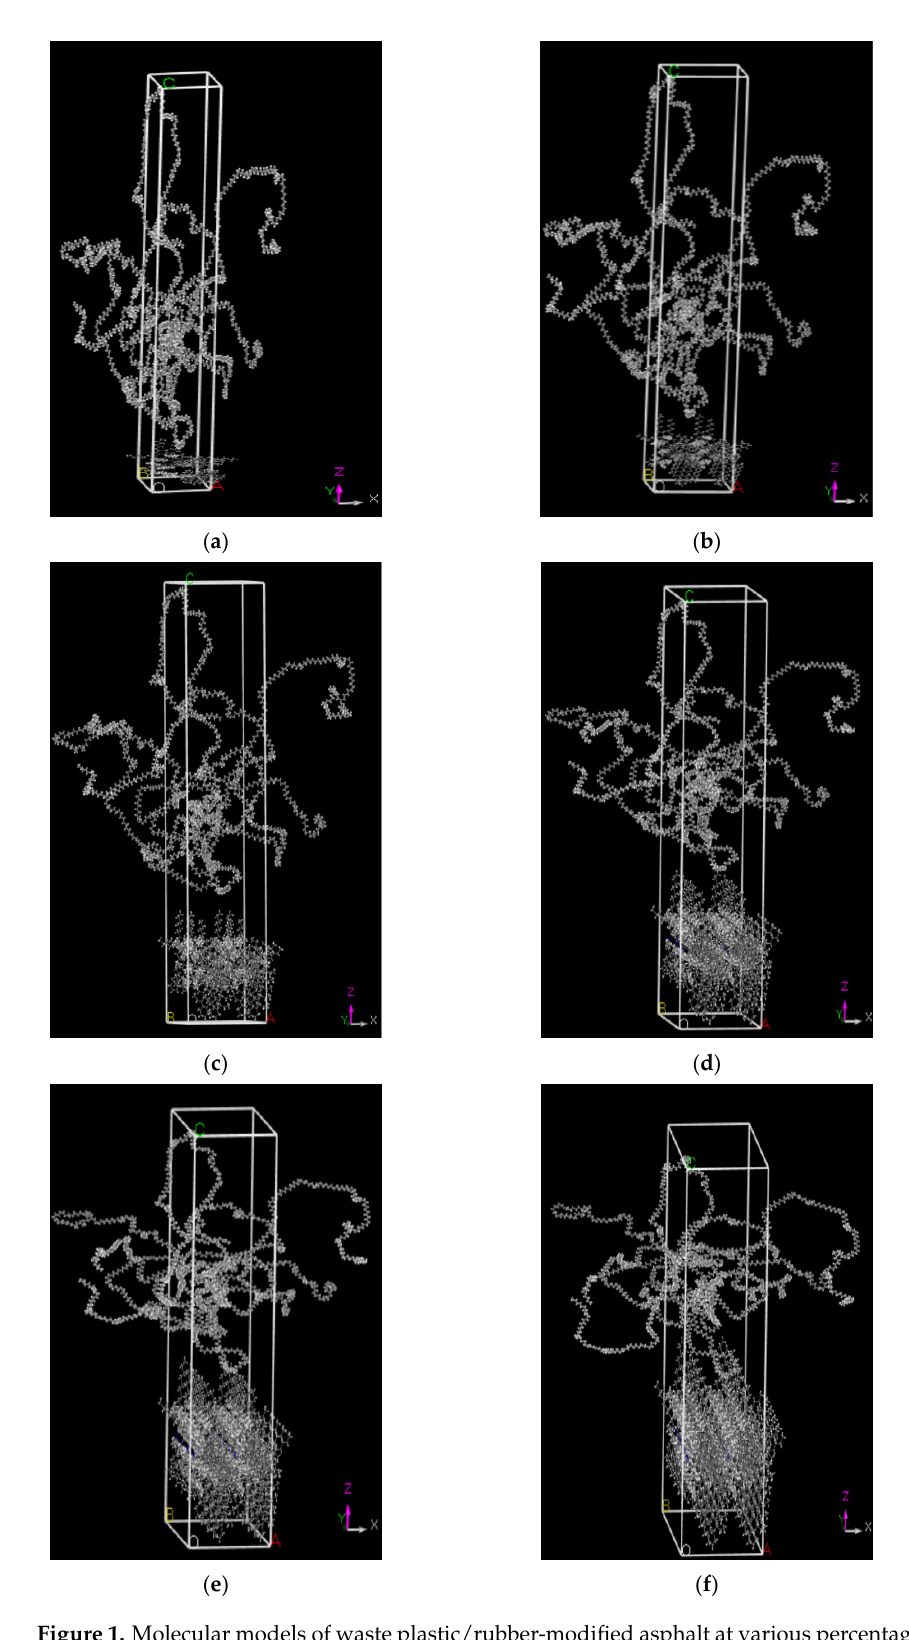
Figure 1. Molecular models of waste plastic/rubber-modified asphalt at various percentages of waste polyethylene: ( a ) 0% waste PE; ( b ) 2% waste PE; ( c ) 4% waste PE; ( d ) 6% waste PE; ( e ) 8% waste PE; ( f ) 10% waste PE.